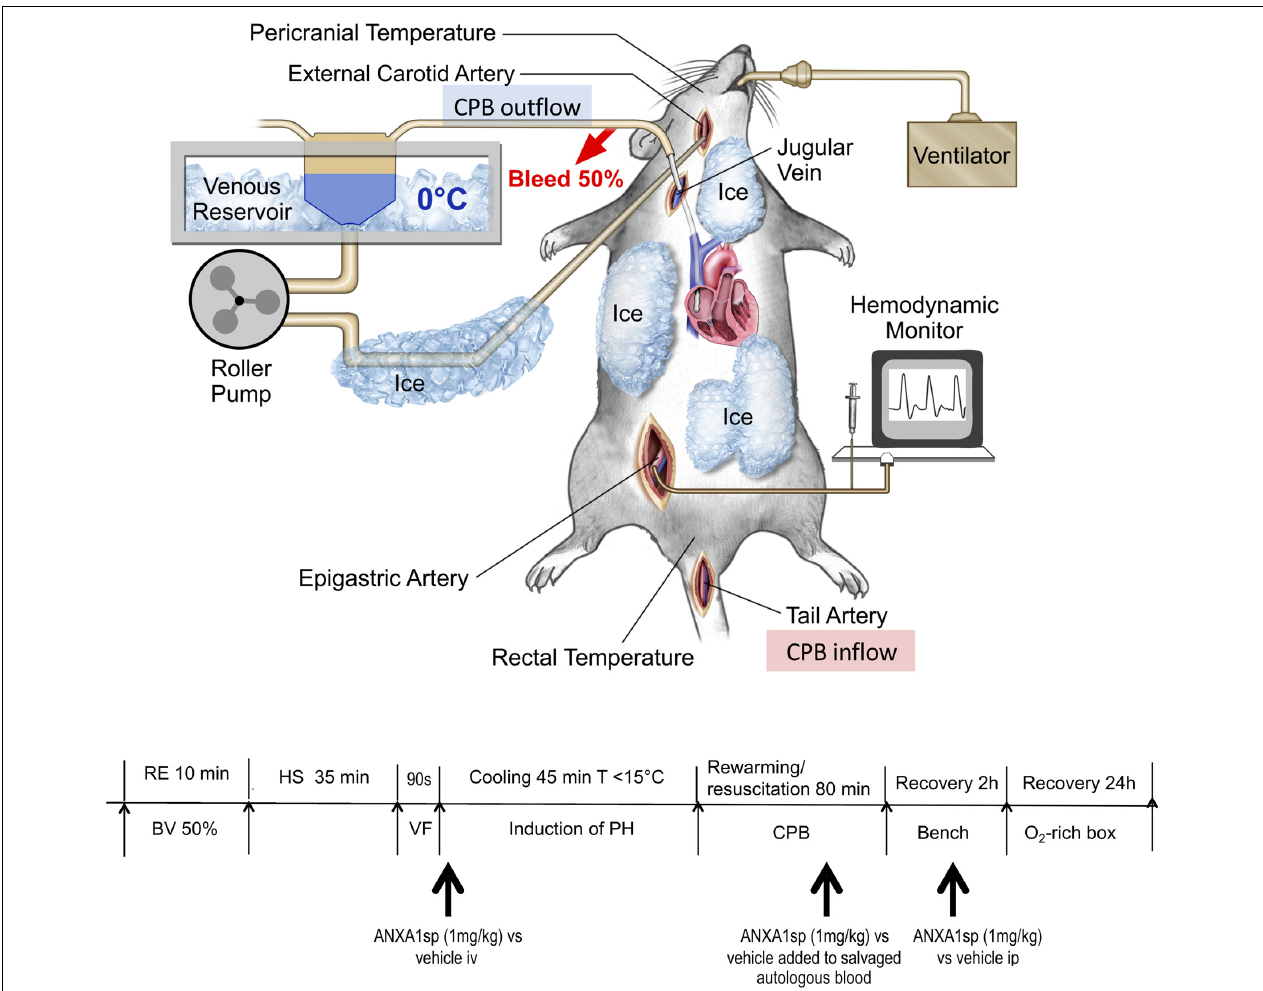
FIGURE 1 | Experimental model of exsanguination cardiac arrest including rapid hemorrhagic shock followed by 90 s of fibrillatory arrest, induction of profound hypothermia ( < 15 ◦ C), resuscitation and rewarming on CPB (emergency preservation and resuscitation, EPR) – diagram of surgical model and experimental timeline. RE, rapid exsanguination; BV, blood volume; HS, hemorrhagic shock; VF, ventricular fibrillation; PH, profound hypothermia; CPB, cardiopulmonary bypass; ANXA1sp, Annexin A1 short peptide.